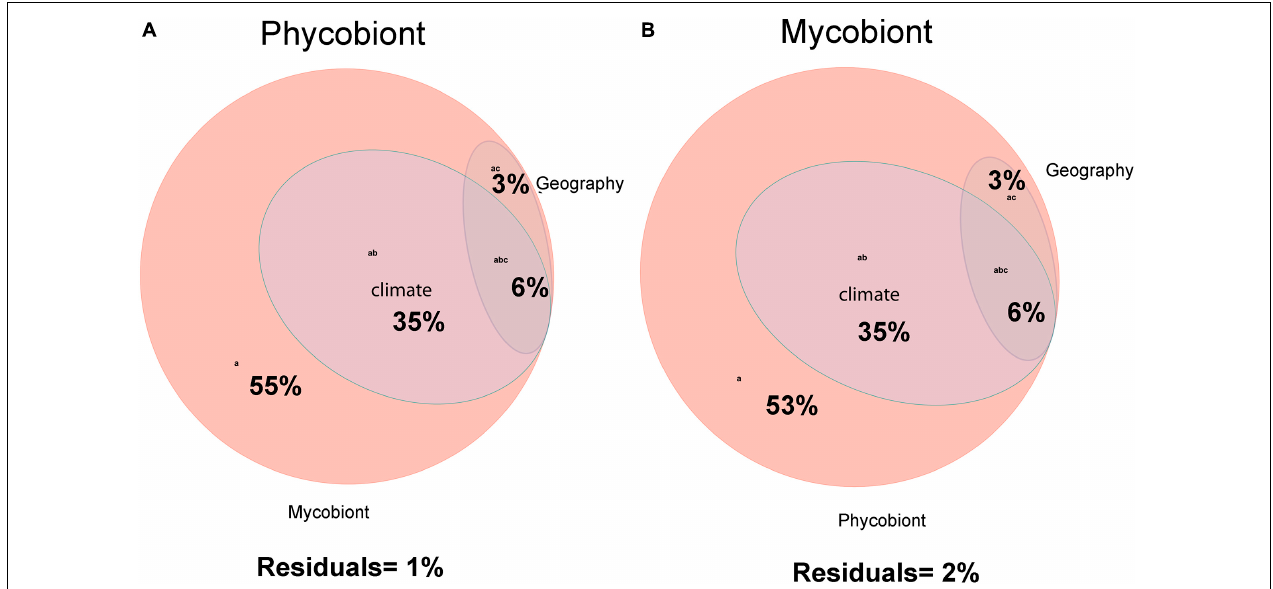
FIGURE 4 | (A) Venn’s diagram showing the variation in distribution of phycobionts associated with the lichen-forming fungal genus Parmelia explained by effects of climate, geography and the mycobiont. (B) Venn’s diagram showing the variation in distribution of Parmelia mycobionts associated with the lichen-forming fungal genus Parmelia explained by effects of climate, geography and the